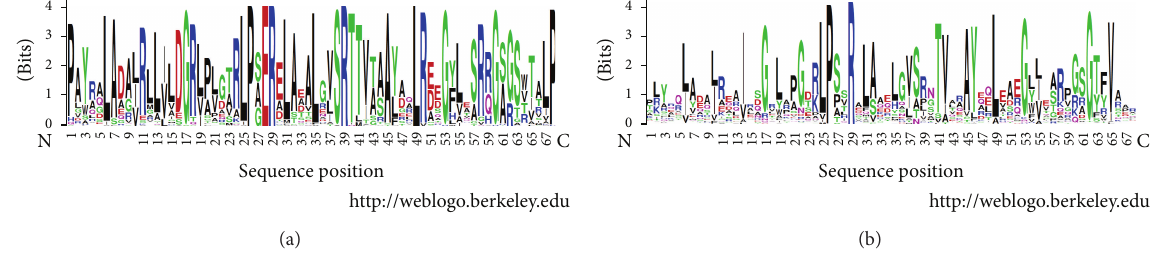
Figure 3: Logos of the alignments of the wHTH domain sequences from (a) YczR and (b) MocR/other. Logos were calculated by the site WebLogo.Residuesarerepresentedwiththeone-lettercode. 𝑥 -axisindicatessequenceposition.Theoverallheightofeachletterstackindicates the sequence conservation at that position, while the height of symbols within the stack indicates the relative frequency of each amino or nucleic acid at that position. Colors reflect chemical-physical residue properties.